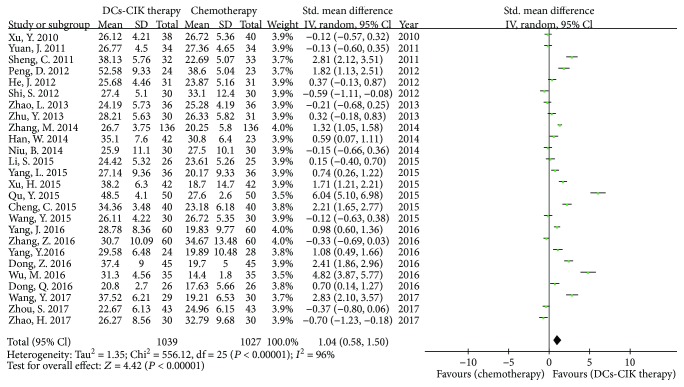
The analysis of CD8+ T cells between the two groups.